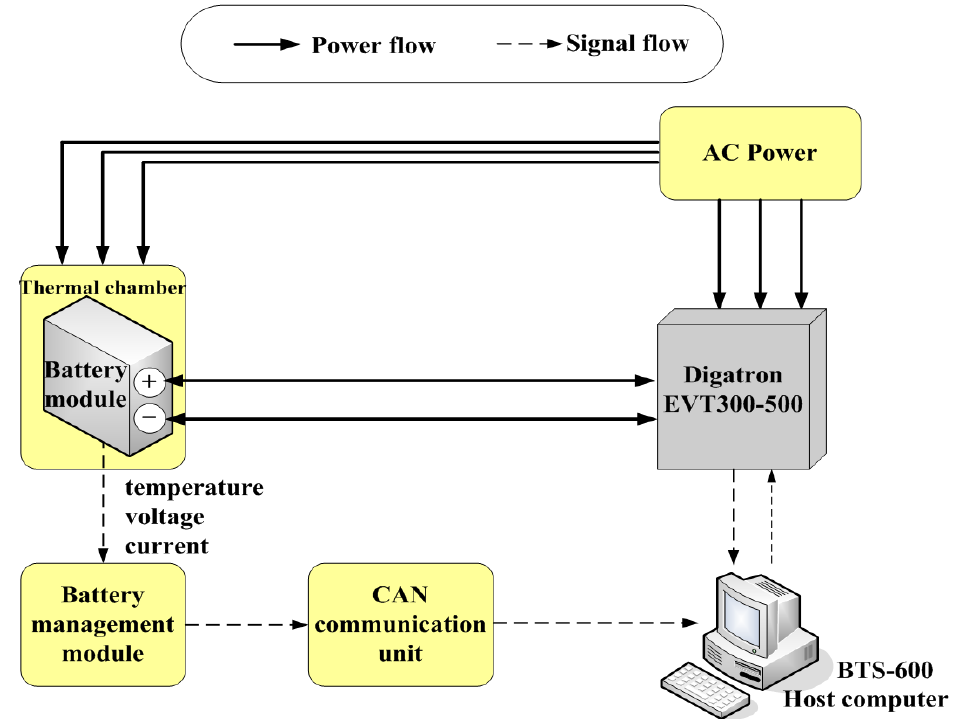
Figure 6. Schematic diagram of the battery testing system.